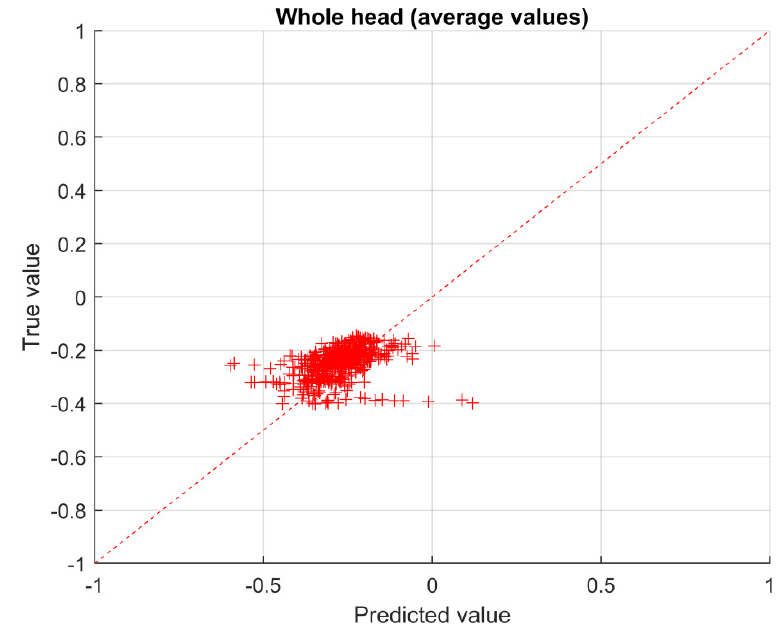
Figure 11. True vs. predicted values for the head region (average values).